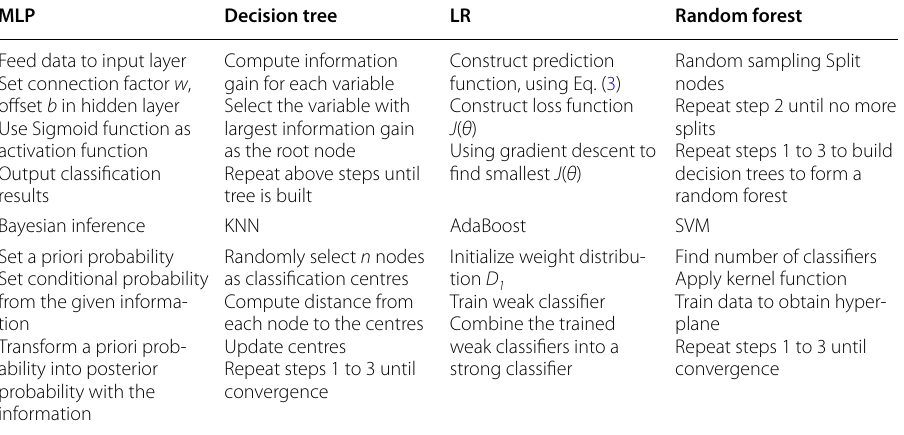
Table 2 Key features of algorithms used MLP Decision tree LR Feed data to input layer Set connection factor w , offset b in hidden layer Use Sigmoid function as activation function Output